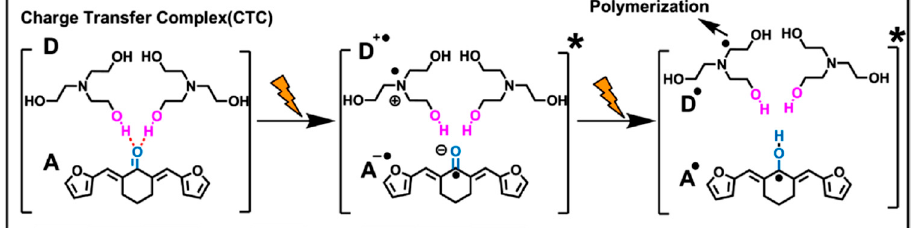
Figure 11. Mechanism involved in the polymerization process with the [BFC/TEOA] CTC . Repro- duced with permission of Ref. [167] (* corresponds to the excited state).